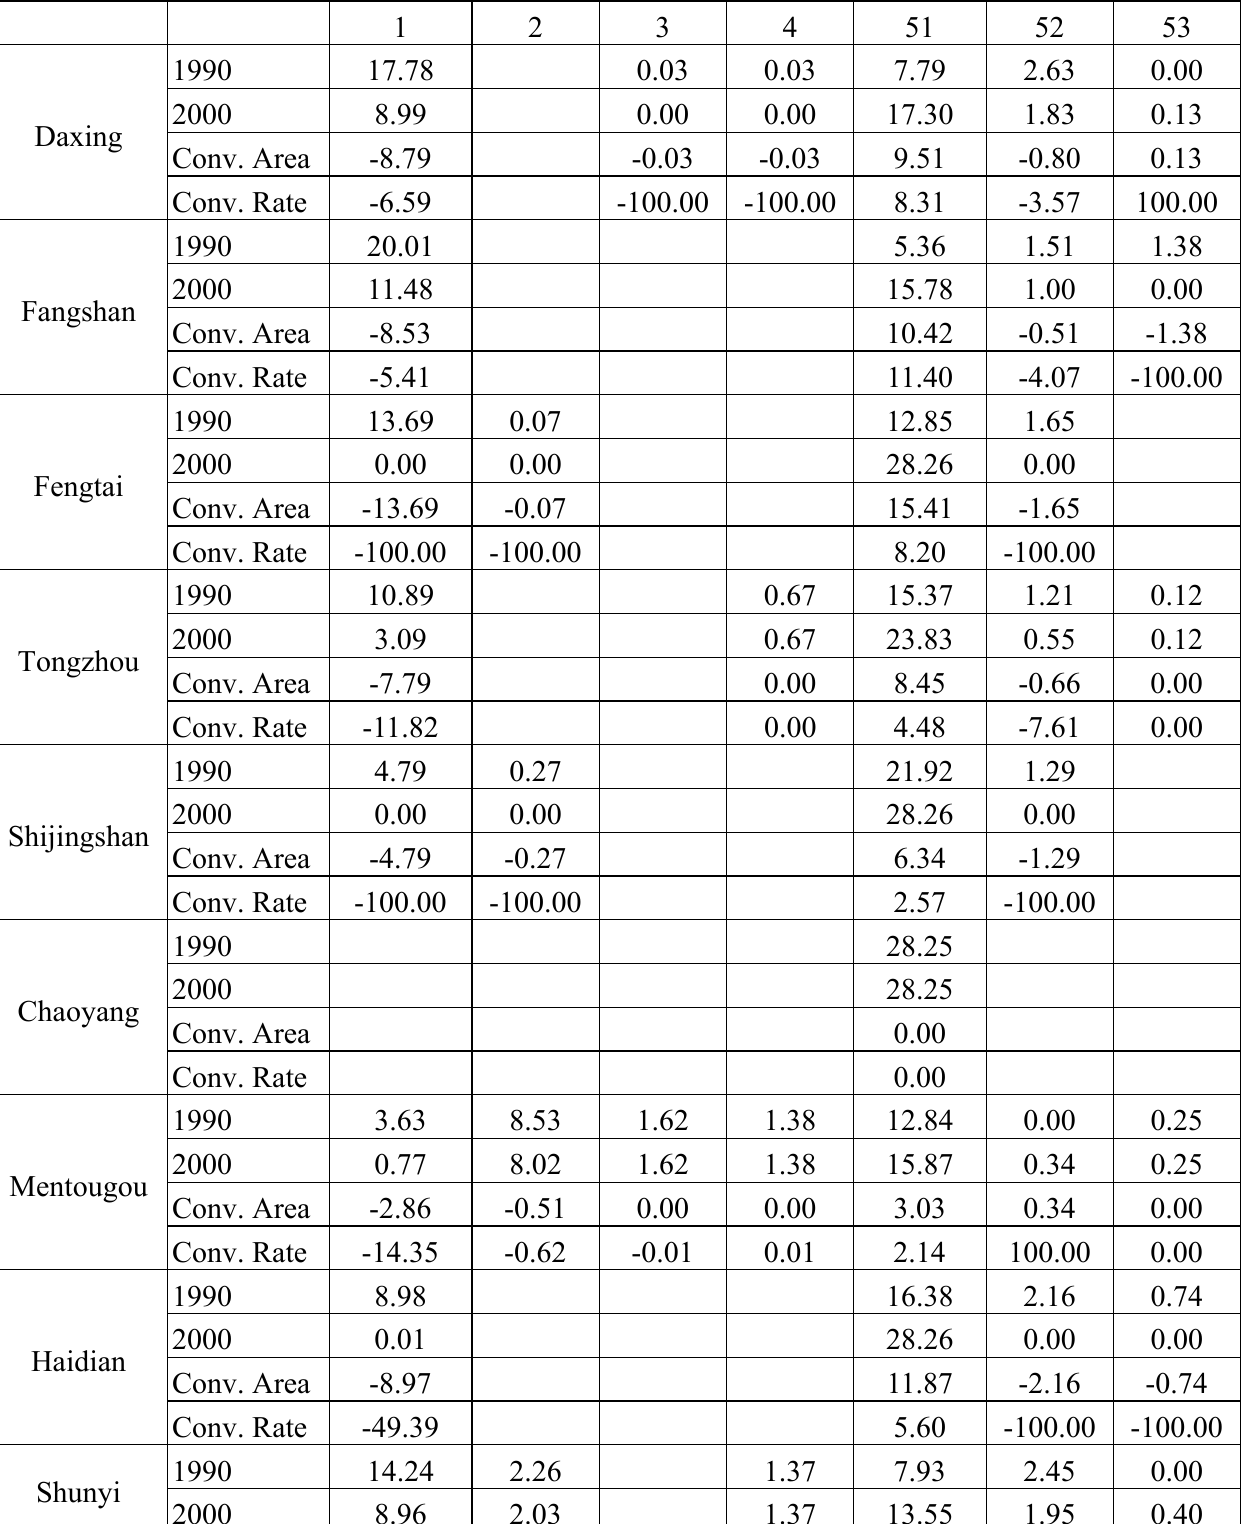
Table 7. Land Use Changes around Business Centers of Beijing Suburban Districts and Counties, 1990 - 2000 (hundred hectare,